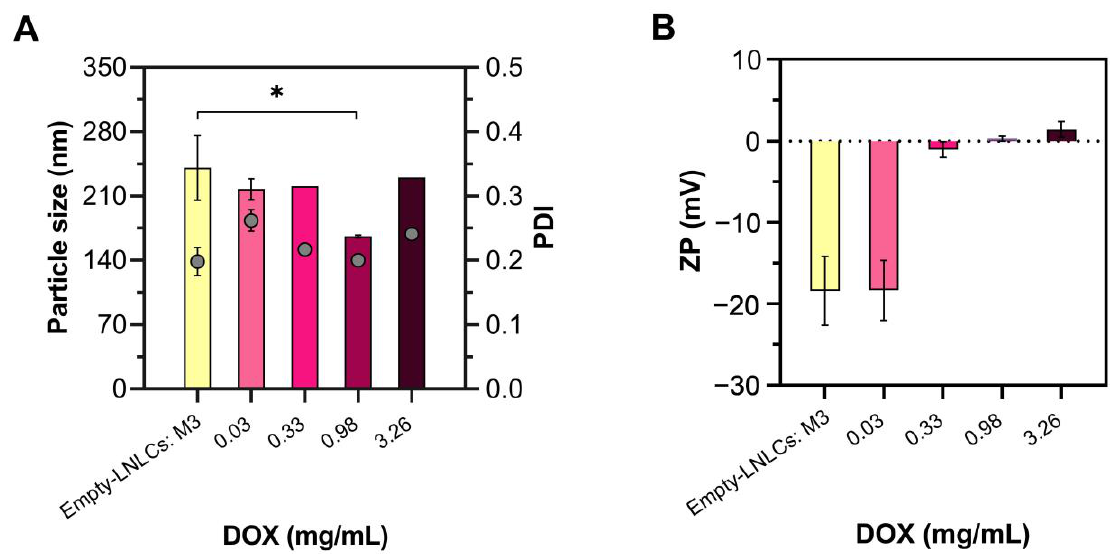
Figure 5. Physicochemical properties of empty LNLCs and DOX-LNLCs with different DOX con- centrations (0.03–3.26 mg/mL): ( A ) size and PDI, and ( B ) surface charge (zeta potential, ZP). Yellow data are the empty LNLCS obtained by the emulsification method (M3); pink data represents the DOX-LNLCs (the colour progression (lightest to darkest) represents the increase in DOX concentra- tion (0.03–3.26 mg/mL)). The data are expressed as mean ± standard deviation of three independent measurements. * p value < 0.05. One-way ANOVA followed by the Bonferroni post hoc comparative test were performed.